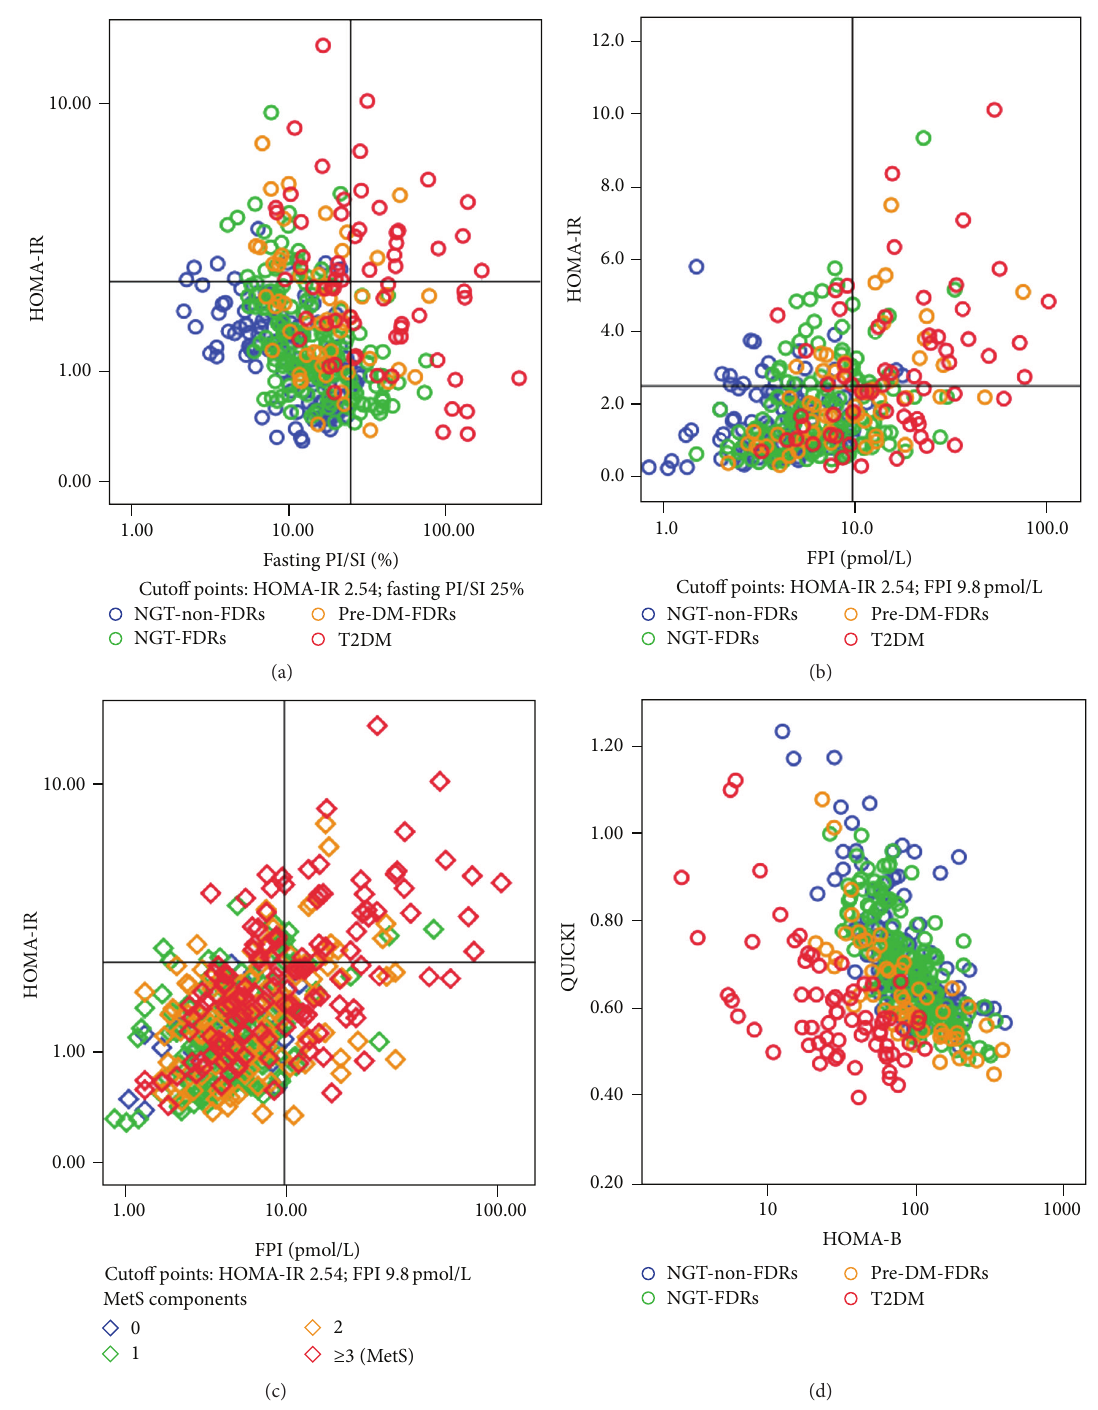
Figure 1: Scatterplots of measures for distinguishing abnormal glucose metabolism (panels (a), (b), and (d)) or metabolic syndrome (panel (c)). Notes: NGT-non-FDRs, normal glucose tolerance subjects with no family history of diabetes; NGT-FDRs, the first-degree relatives of T2DM with normal glucose tolerance; pre-DM-FDRs, first-degree relatives of T2DM with prediabetes; T2DM, type 2 diabetes mellitus; MetS, metabolic syndrome; HOMA-IR, homeostasis model assessment of insulin resistance; HOMA-B, homeostasis model assessment of beta-cell function; QUICKI, quantitative insulin sensitivity check index; PI, proinsulin; SI, specific insulin; PI/SI, proinsulin-to-specific insulin